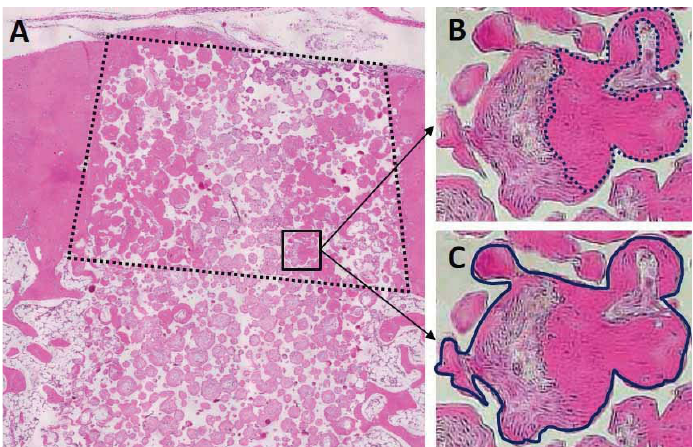
Figure 4- Schematic drawing of hstomorphometric analysis. The ratio of bone formation was measured in the cortical bone area (A, dashed box). It was calculated as the ratio of the area of newly formed bone (B, inside the dotted line) to that of the total regenerated tissue (C, inside the solid line) (cid:90)(cid:68)(cid:86)(cid:3)(cid:84)(cid:88)(cid:68)(cid:81)(cid:87)(cid:76)(cid:191)(cid:72)(cid:71)(cid:3)(cid:68)(cid:86)(cid:3)(cid:87)(cid:75)(cid:72)(cid:3)(cid:85)(cid:68)(cid:87)(cid:76)(cid:82)(cid:3)(cid:82)(cid:73)(cid:3)(cid:74)(cid:72)(cid:81)(cid:72)(cid:85)(cid:68)(cid:87)(cid:72)(cid:71)(cid:3)(cid:69)(cid:82)(cid:81)(cid:72)(cid:3)(cid:87)(cid:82)(cid:3)(cid:87)(cid:75)(cid:72)(cid:3)